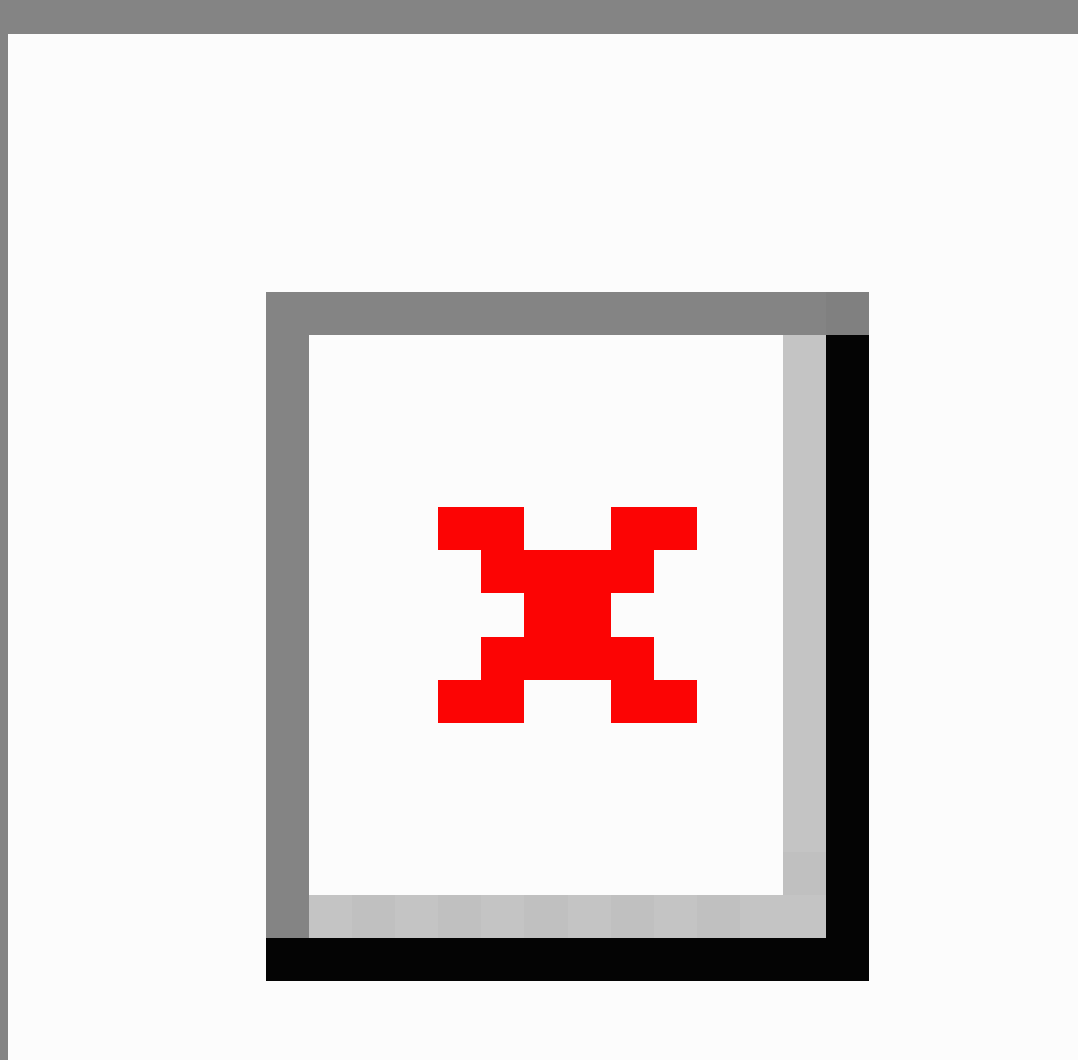
Figure 8. Evaluation of accuracy of models trained to predict ten year survival using gene sets derived from the game, and prior gene sets from